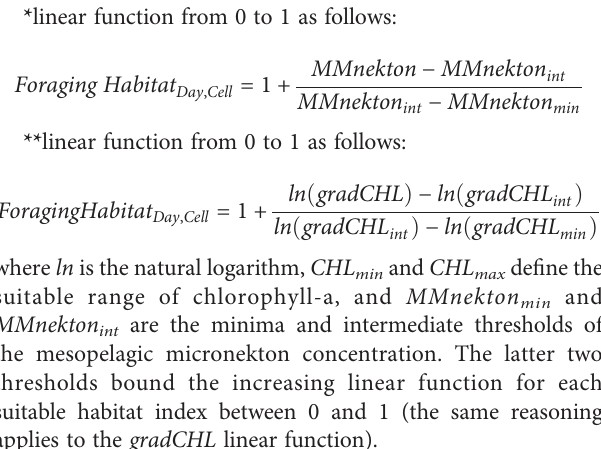
TABLE 1 | Calibration parameters for the biotic variables of the blue shark foraging habitat model. Biotic parameter values for blue shark foraging habitat